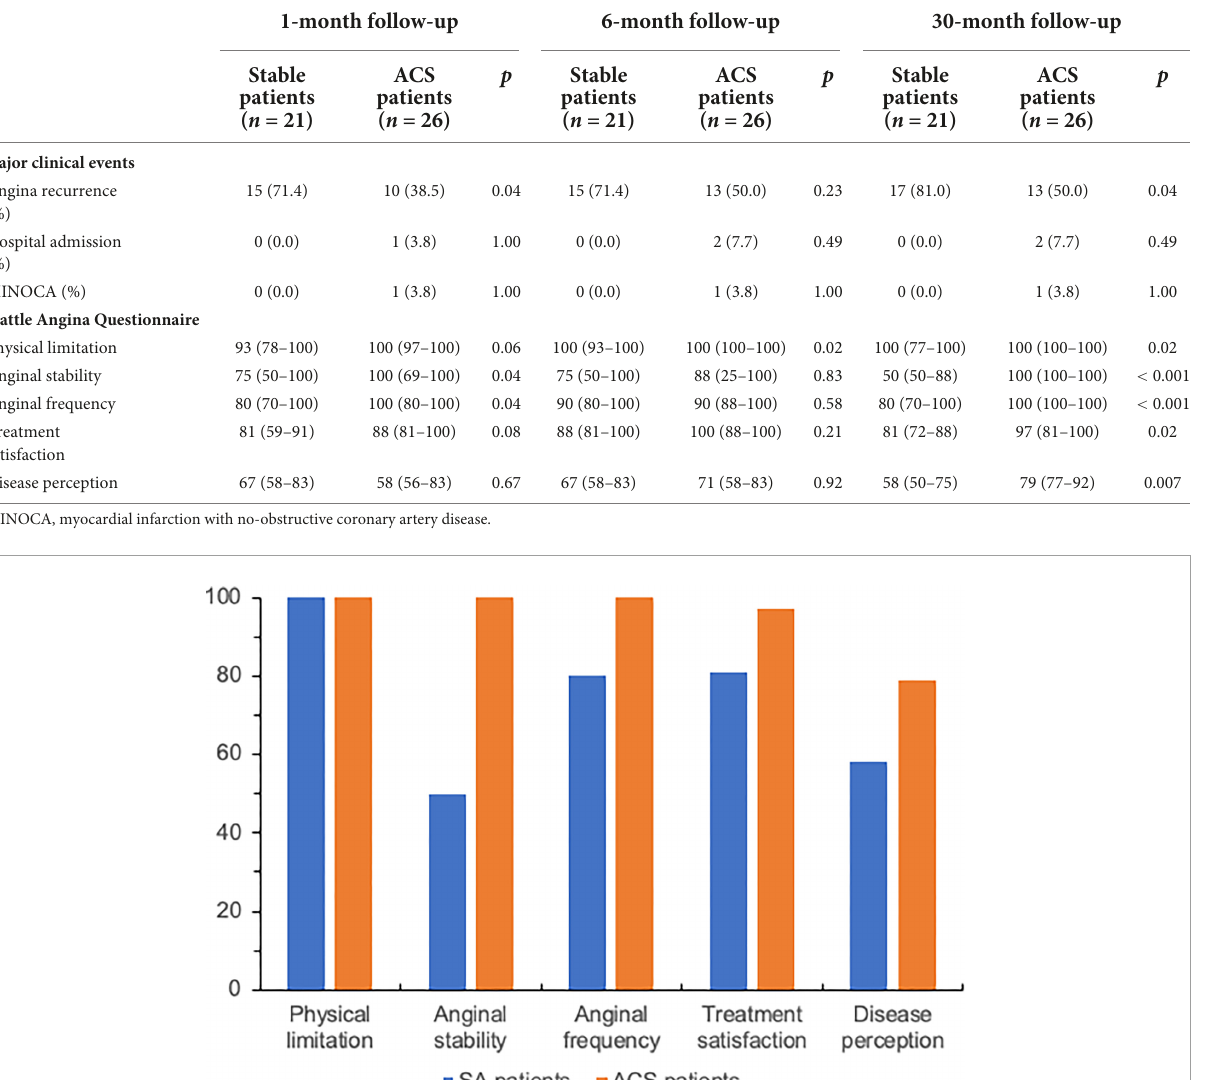
TABLE 3 Clinical outcomes of the two groups of patients.